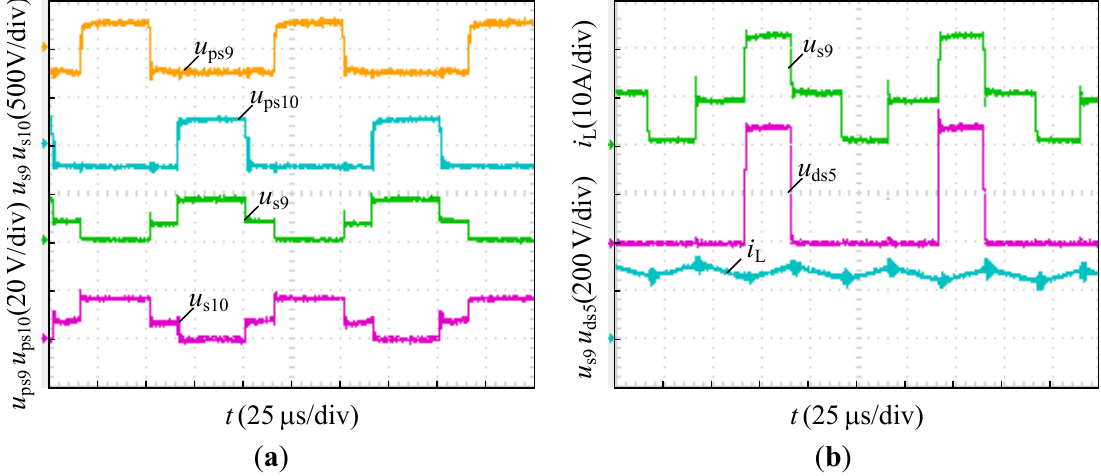
, S ; ( b ) Voltage stress of S 9 10 , and inductor current. 5